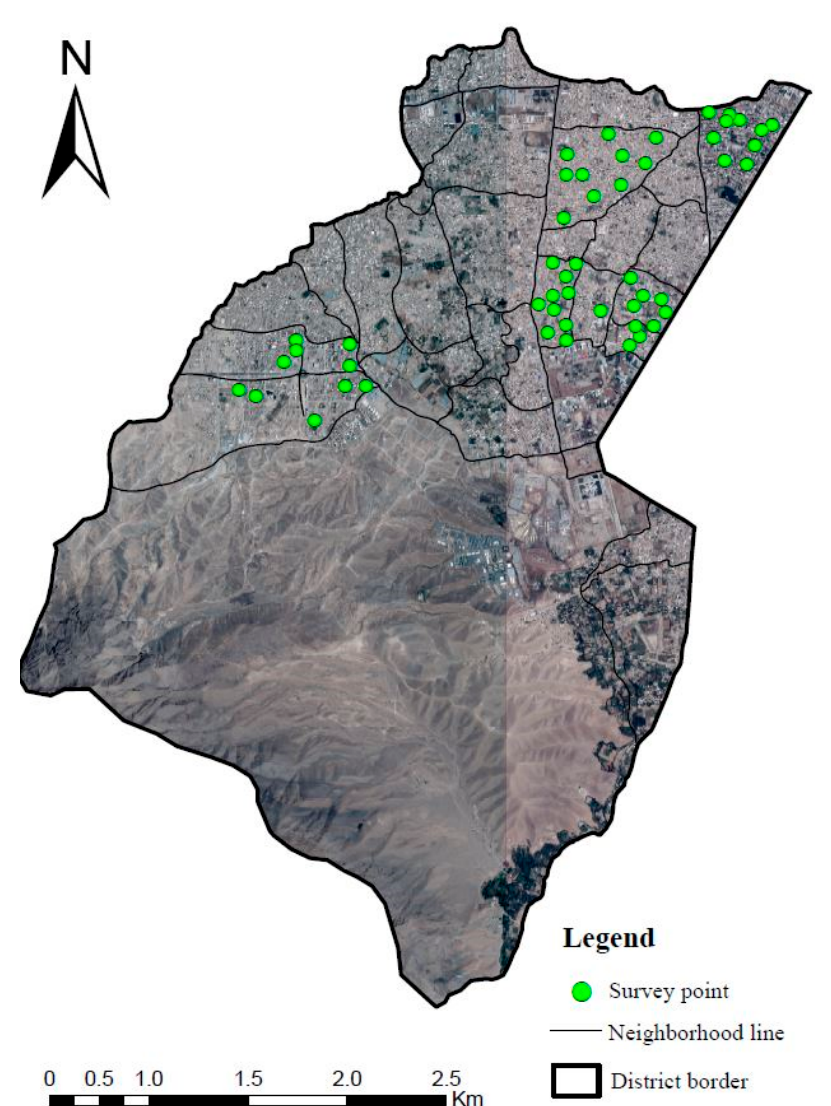
Figure 4. Map of District 6 with neighborhood boundaries and investigated sites.